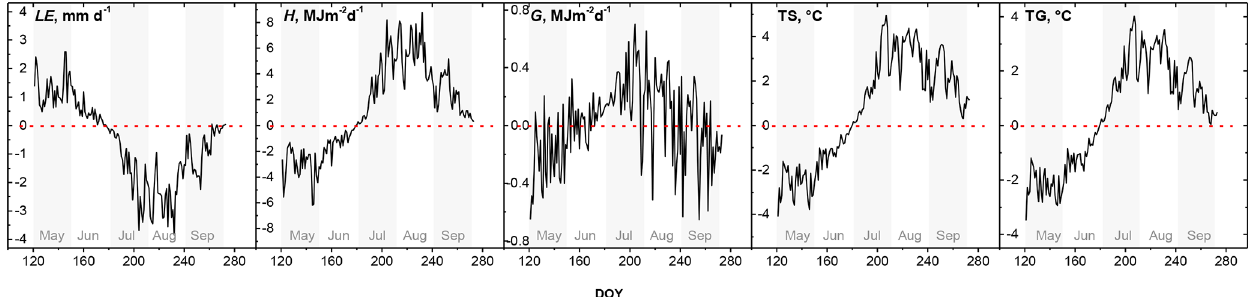
Figure 3. Differences (ECC minus LCC) in latent heat flux ( LE ), sensible heat flux ( H ), ground heat flux ( G ) , mean surface temperature (TS) and mean ground temperature (TG) between simulations for ECC and LCC. Table 4. Mean differences (ECC minus LCC) in latent heat flux ( LE ), sensible heat flux ( H ), ground heat flux ( G ), mean surface temperature (TS) and mean ground temperature (TG) between ECC and LCC simulations.